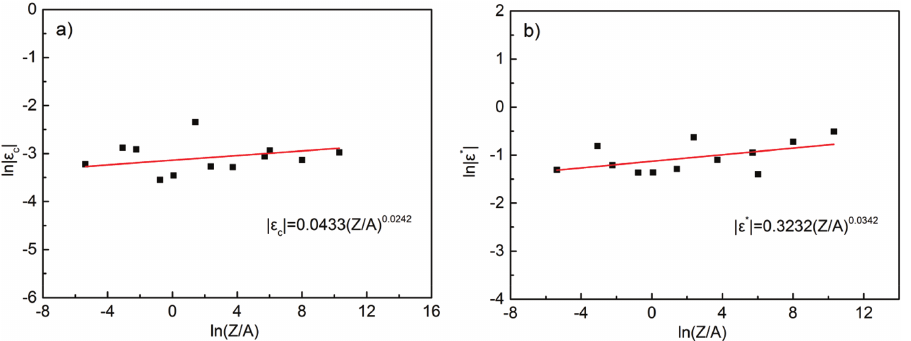
Figure 8: Relationships between the ln( Z / A ) and (a) ln| ε c |; (b) ln| ε *